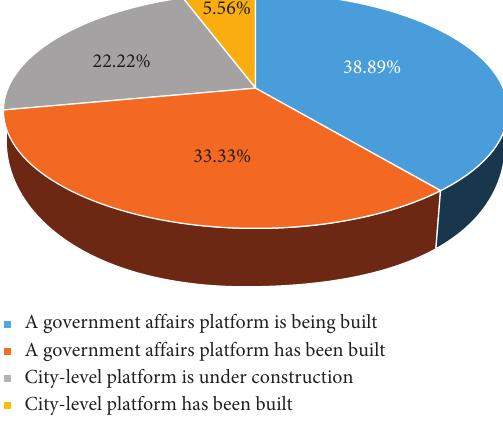
Figure 1: Construction of urban Big Data